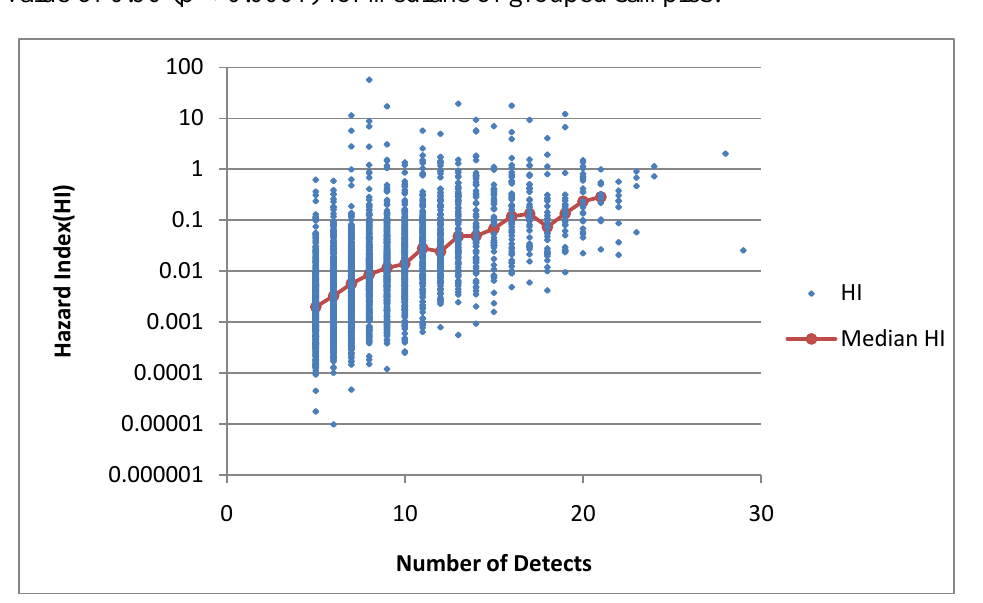
Figure 2. The relationship between HI and n for Case 1. HI and n have a strong positive correlation, Kendall’s tau-b value of 0.44 (p < 0.0001) based on all samples and Kendall tau-b value of 0.96 (p < 0.0001) for medians of grouped samples.